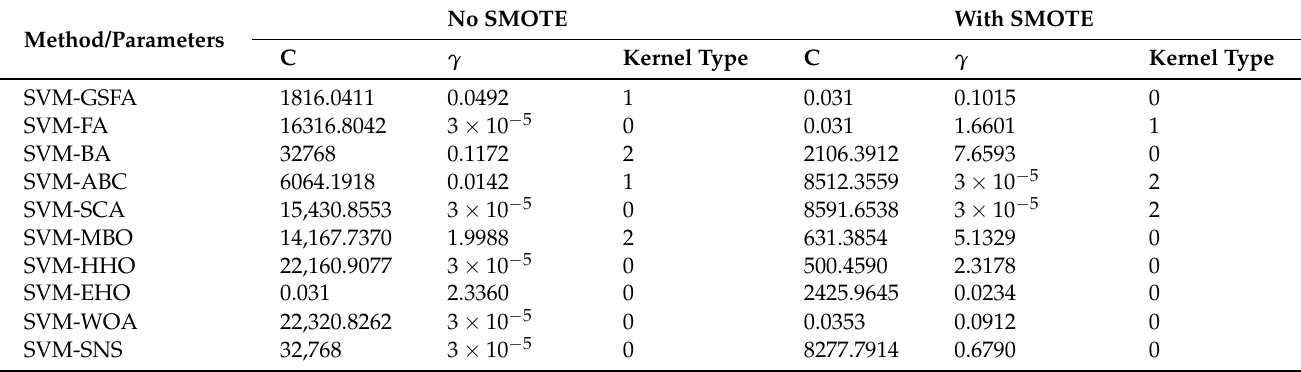
Figure 6. Precision–recall curves for SVM, ELM, and XGBoost models tuned by GSFA and arbitrary chosen approaches for synthetic credit card fraud dataset Lastly, the hyper-parameters’ values for the tuned SVM, ELM, and XGBoost mod- els, generated in the best run for each applied optimization algorithm, are shown in Tables 14–16, respectively. It should be noted that Table 15 depicts just the number of neurons nn parameter that obtained the best results, as showing all weights and biases parameters would not be feasible. Table 14. Best SVM parameters’ values obtained by the analyzed